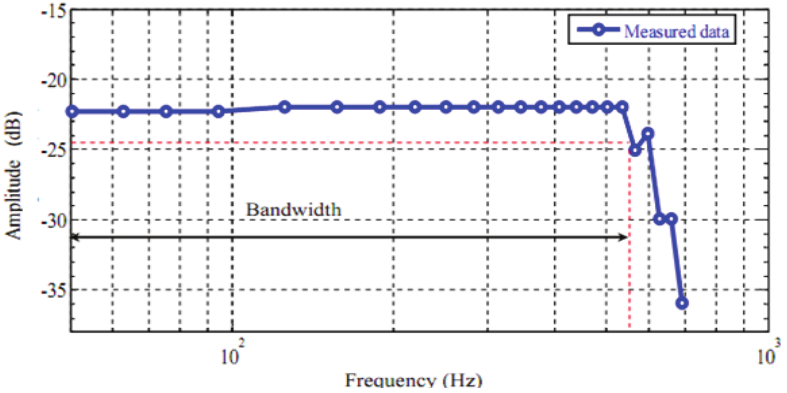
Figure 17. Variation of the deflection with the frequency for bimorph actuator